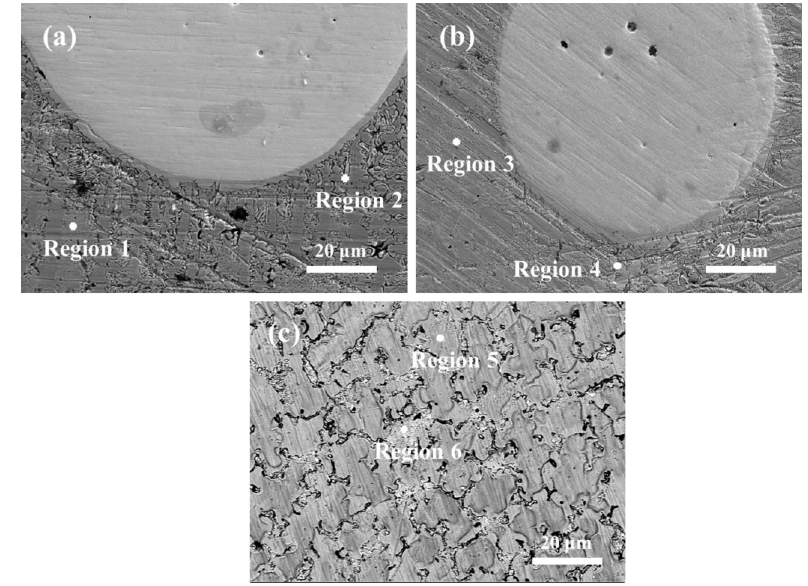
Figure 2: Surface SEM of composite coatings: ( a ) Ni + 30% WC; ( b ) Ni + 15% WC; ( c )